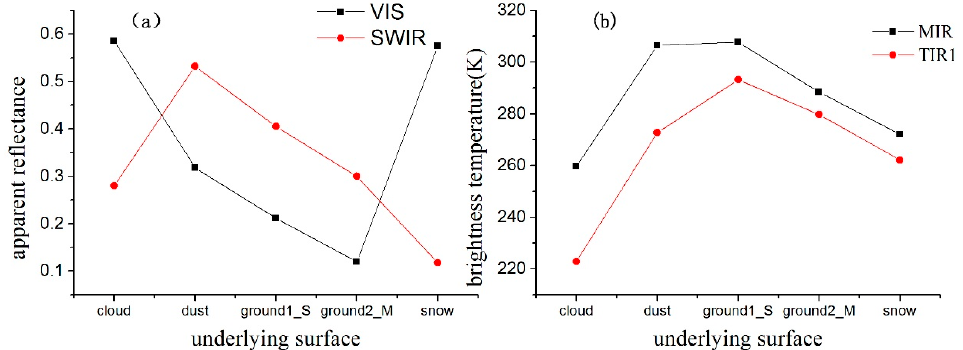
Figure 2. Spectral response characteristics of INSAT-3D: ( a ) the apparent reflectance of VIS (0.65 μ m) and SWIR (1.6 μ m); and ( b ) brightness temperature of MIR (3.9 μ m) and TIR1 (10.8 μ m) against five underlying surfaces: cloud, dust, sand ground (ground1_S), non-sand ground (ground2_M) and snow.